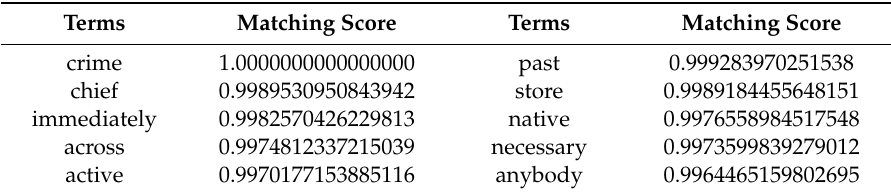
Table A5. Top terms for term crime.